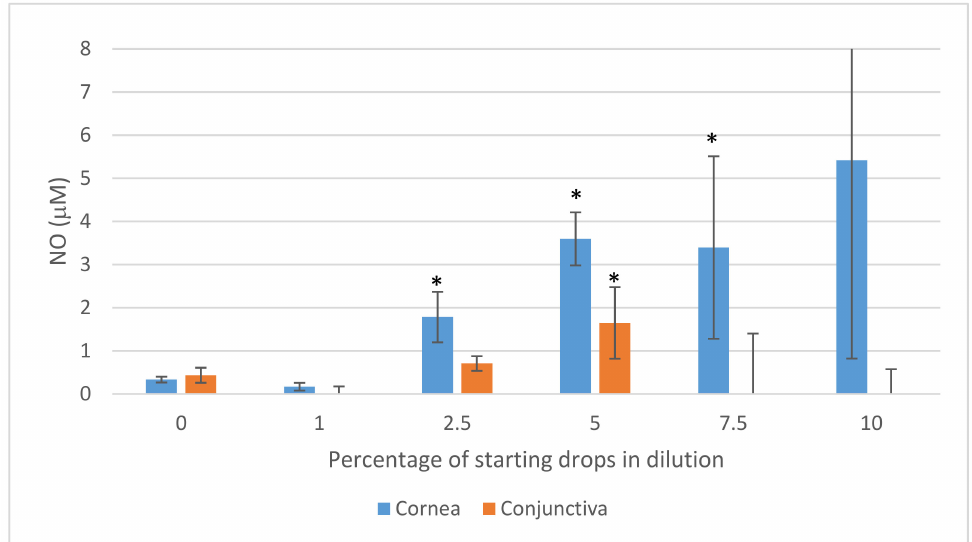
Figure 5. Nitric oxide (NO) secretion in a culture of human corneal and conjunctival epithelium, during 24 h of incubation with Ozodrop ® preparation. The concentration range of starting drops dilution was 0–10%. Analysis was performed using the Griess method. Columns and bars show the mean ± standard deviation ( n = 3). * p ≤ 0.05—a culture of corneal or conjunctival epithelial cells treated with Ozodrop ® preparation, as compared to a non-treated culture